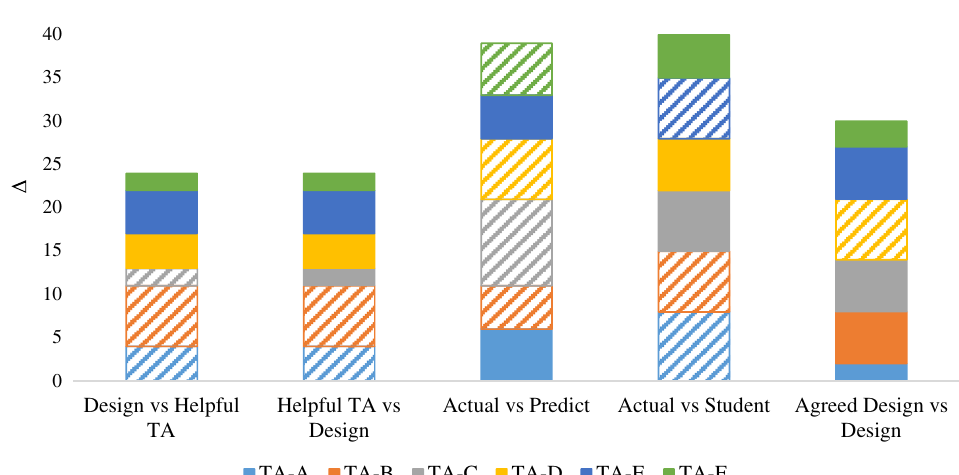
FIG. 5. A representation of the Δ ’ s for each group of comparisons. Only the smallest Δ ’ s for select groups are shown. Two Δ ’ s are shown for the “ Actual ” group due to the two comparisons having similar Δ ’ s (39 and 40). Each section separated by color in each bar represents a TA ’ s δ . If that section is striped it indicates that this was not the most similar comparison for that group for that